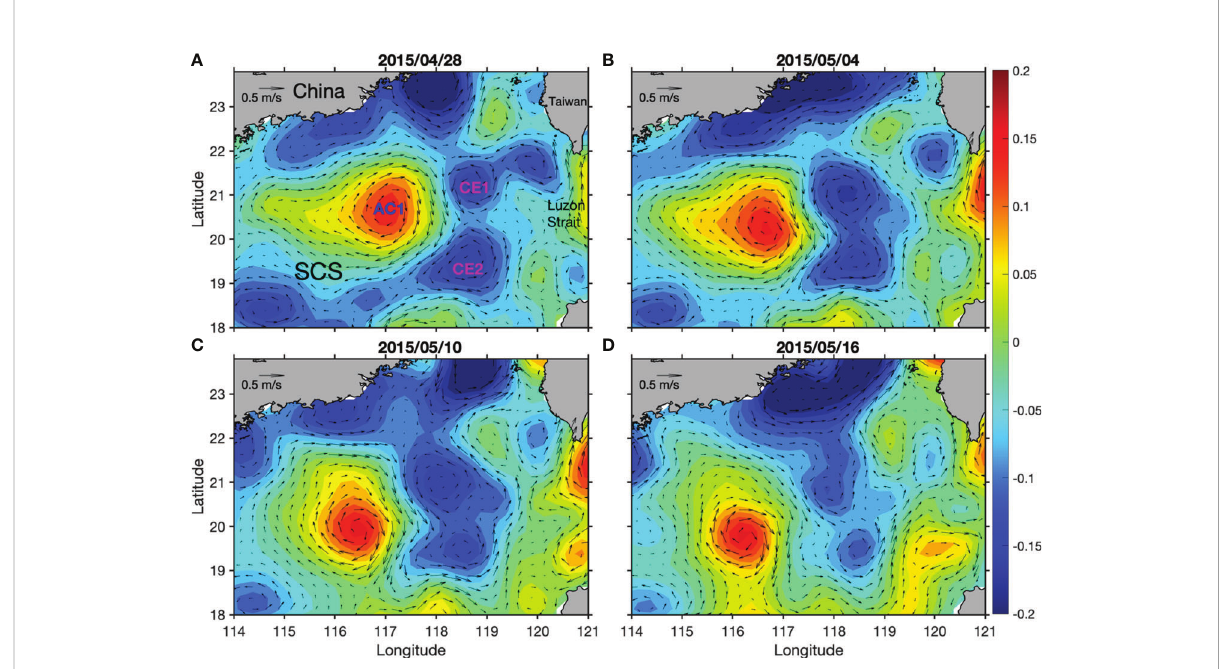
FIGURE 1 Time evolutions of SLA (units: m) overlaid by geostrophic current anomalies on 28 April (A) , 04 May (B) , 10 May (C) and 16 May 2015 (D) .